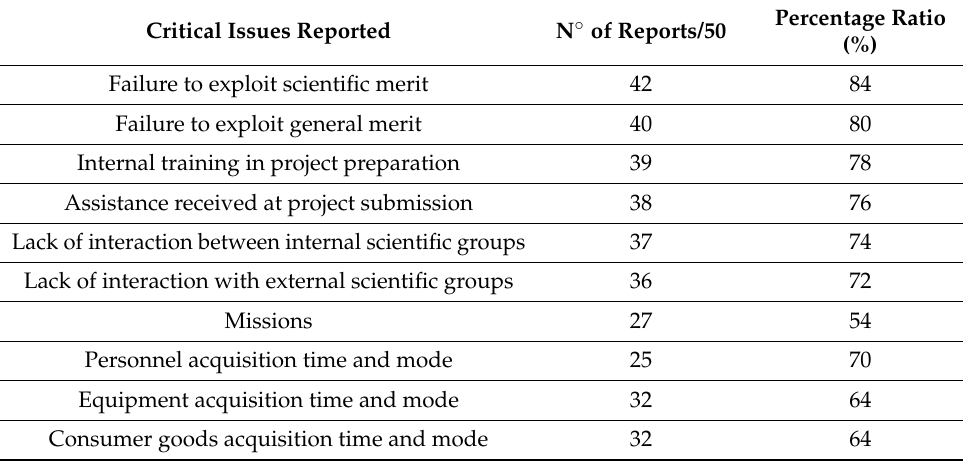
Table 1. Main issues reported in the barrier identification questionnaire.